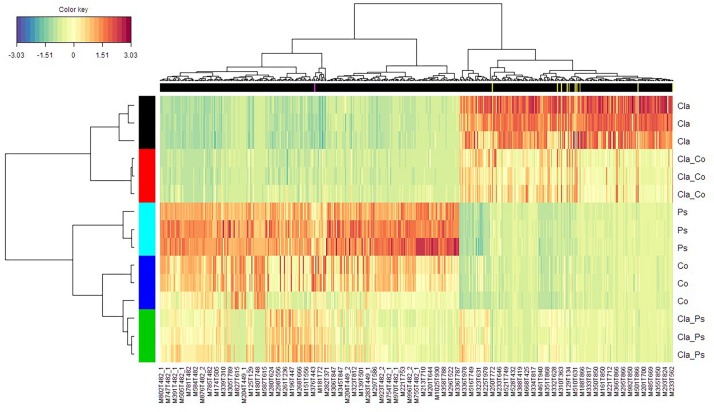
Heatmap displaying both the culture clusters in rows and the clusters of variables (m/z) in columns. Ps, Pseudoalteromonas; Co, Cobetia monocultures; Cla, Cladosporium monocultures; Cla-Ps, Cladosporium-Pseudoalteromonas co-cultures; Cla-Co, Cladosporium-Cobetia co-cultures. For convenience, not all variables are labeled. In the black banner are given variables marked in yellow and pink vertical lines for Cla-Co and Cla-Ps co-cultures, respectively, which were significantly filtered according to (i) a VIP value above 1.20 (and with respective SE values lower than VIP), and (ii) an absolute value of the correlation between the variables selected at the previous step and the PLS component which is above 0.75.